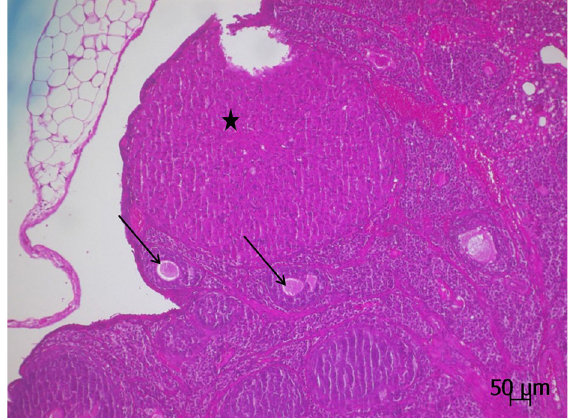
Figure 2. Biochemical analysis results of COX-1 and COX-2 parameters. Values are expressed as mean ± SEM.